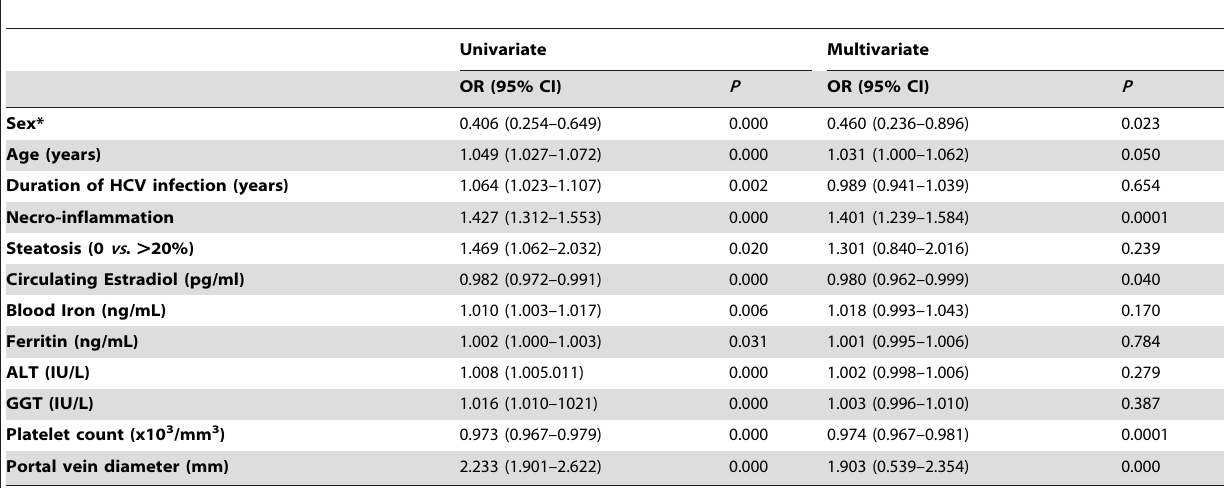
Table 2. Univariate and multivariate analysis for fibrosis in the whole cohort of patients with chronic hepatitis